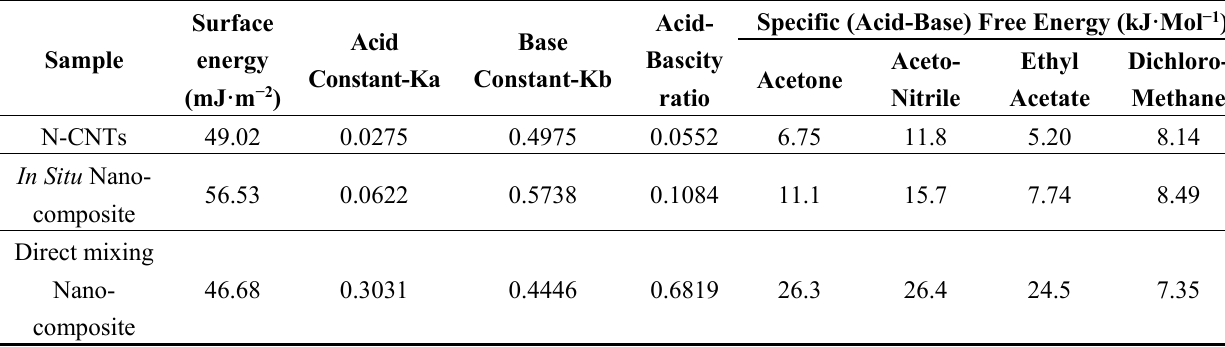
Table 1. (cid:2011) (cid:3046)(cid:3031) , acid-base constants determined from interaction with polar probes.